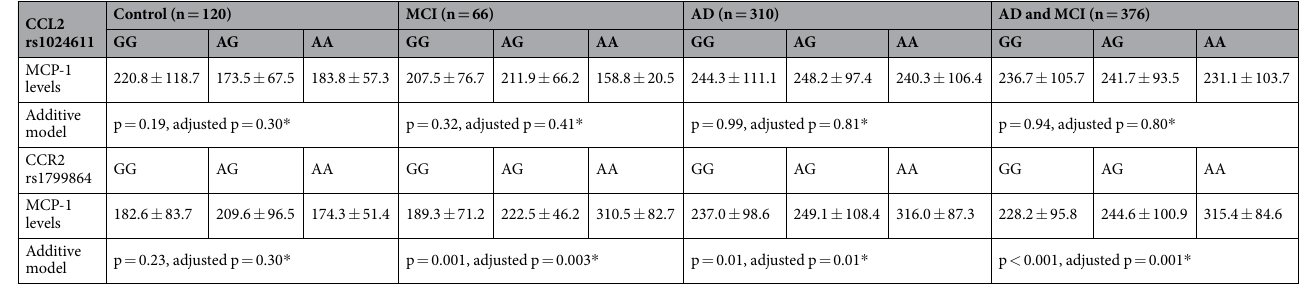
Table 6. The relationship between the CCL2 and CCR2 genotypes and plasma MCP-1 levels in AD patients, MCI patients, and control subjects. The values indicate means with standard deviations. MCI, mild cognitive impairment; AD, Alzheimer’s disease; CCL2, Chemokine ligand 2; CCR2, CC-chemokine receptor 2; MCP-1, Monocyte chemoattractant protein-1. * Multivariate linear regression model adjusting age, gender, APOE ε 4 carrier status, and Charlson comorbidity